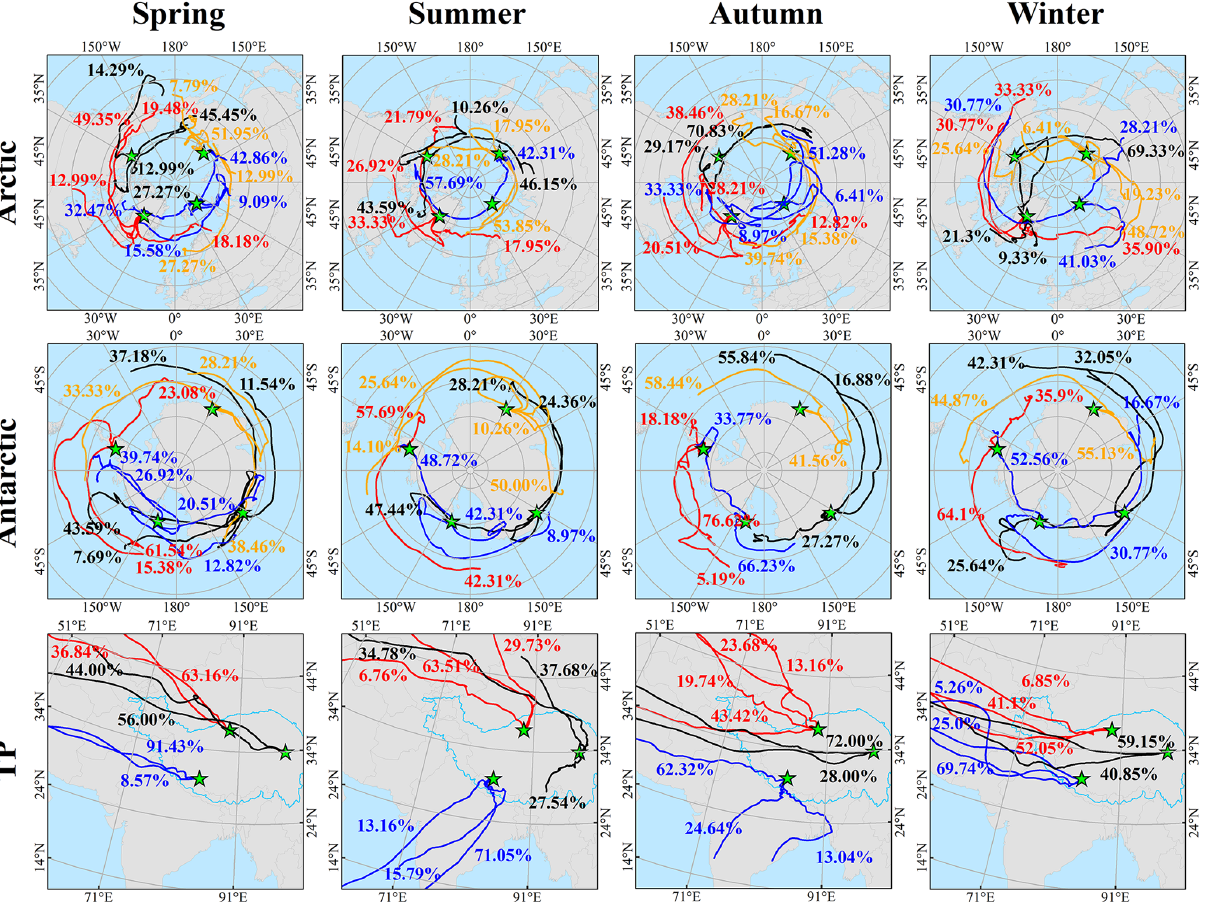
Figure 8. The seasonal-average characteristics of the back trajectories for the study period from January 2007 to December 2019 at each selected site over the Arctic, Antarctic and